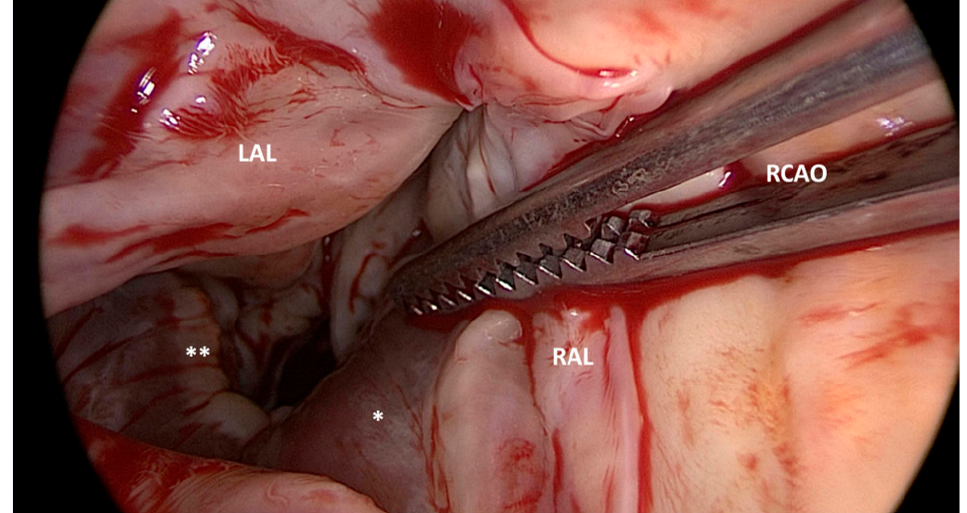
Figure 2. Surgical view of left ventricle outflow tract (LVOT) obstruction and the bulging of the interventricular septum ( * ) after left and right aortic valve leaflet retraction (LAL and RAL). RCAO: right coronary artery ostium. Jet lesions ( ** ) produced by turbulence in the LVOT.